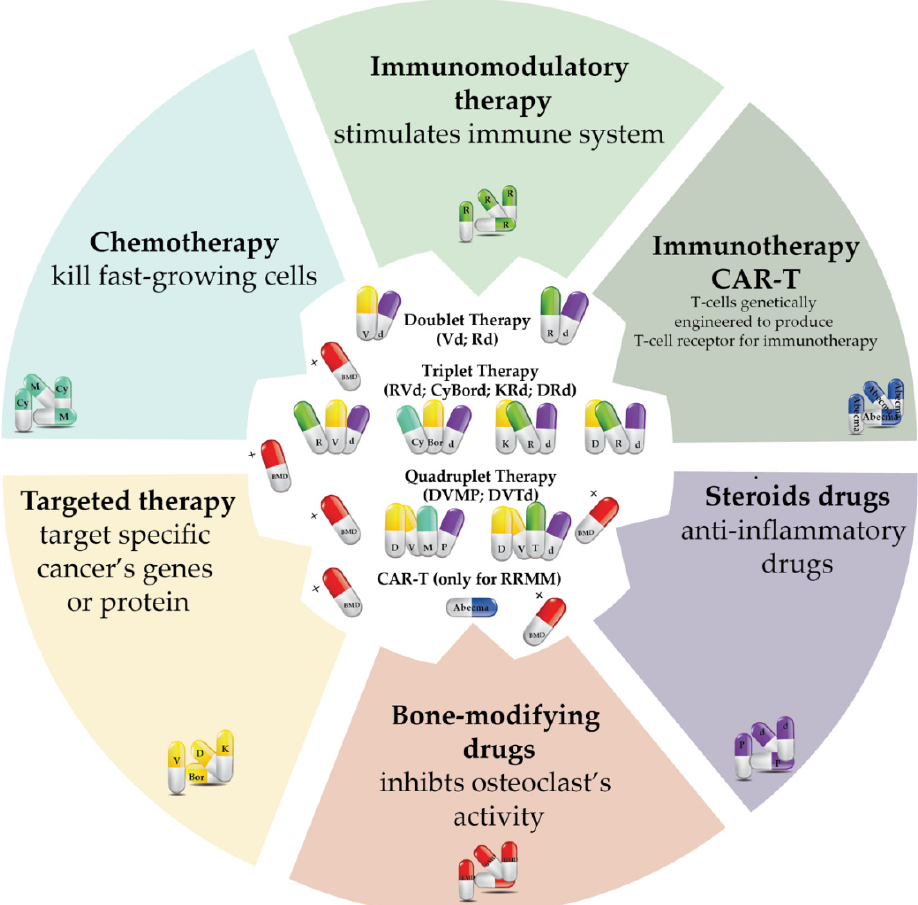
Figure 3. Most common combined and approved regimens for treatment of multiple myeloma. Drugs with a different mechanism of action can be used synergistically, resulting in duplet, triplet, or quadruplet therapy depending on the number of used combined drugs. Therapies are named using the first letter of the commercial drug name or active ingredient. Bone-modifying drugs are